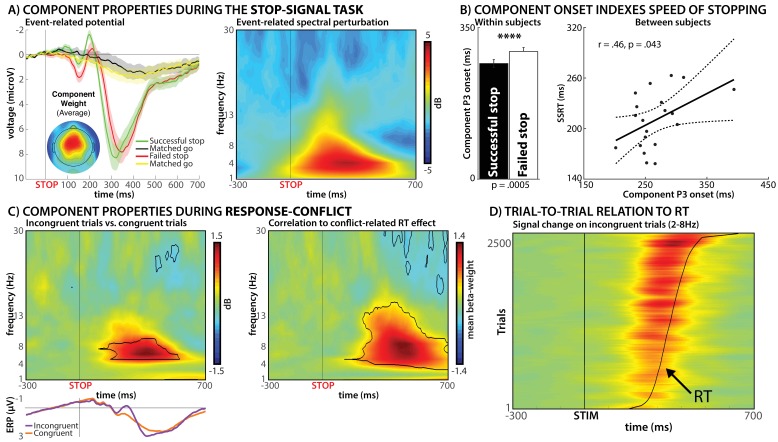
Results from Experiment 1.(A) Group-average event-related potential and event-related spectral perturbation of the selected independent EEG source-signal components during the stop-signal task. The left panel shows the event-related stop-signal P3 activity of these components, while the right panel shows that the bulk of the signal increase of these components during successful stopping is found between 2 and 8 Hz. (B) Relationship between the onset of the event-related part of the components in panel A to behavioral measures of motor inhibition in the stop-signal task. The onset of the stop-signal P3 occurred significantly earlier in successful vs. failed stop-trials (left panel). Moreover, the latency of P3 onset was positively correlated with the speed of stopping across subjects (right panel). (C) Activity of these same components during response-conflict in the Simon task. The left panel shows a significant (p<0.01, FDR-corrected) increase in low-frequency activity on incongruent vs. congruent trials on the group-level. The right panel shows the results of a trial-by-trial correlation between the degree of motor slowing on each individual incongruent trial and the activity of the selected components, revealing a positive relationship between the same low-frequency activity and motor slowing during response-conflict. (D) Illustration of that same relationship on individual trials, stacked across all subjects (for visualization purposes only). Y-Axis shows individual incongruent trials, sorted by reaction time (curved black line). Stronger low-frequency activity can be observed on trials with more motor slowing (top of graph).